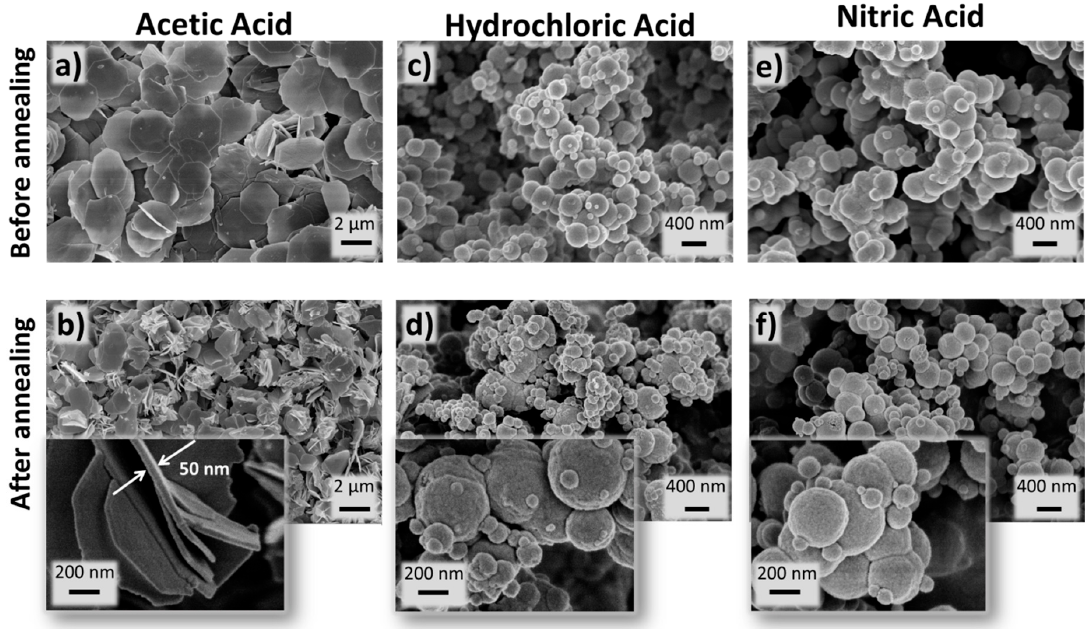
Figure 6. Scanning electron microscopy (SEM) images of Yb/Eu doped Y 2 O 3 nanostructures produced by hydrothermal method assisted by microwave radiation, and using ( a ) and ( b ) acetic acid, ( c ) and ( d ) hydrochloric acid and ( e ) and ( f ) nitric acid, before and after annealing at 700 ° C, respectively. The insets magnify the structures produced after calcination.